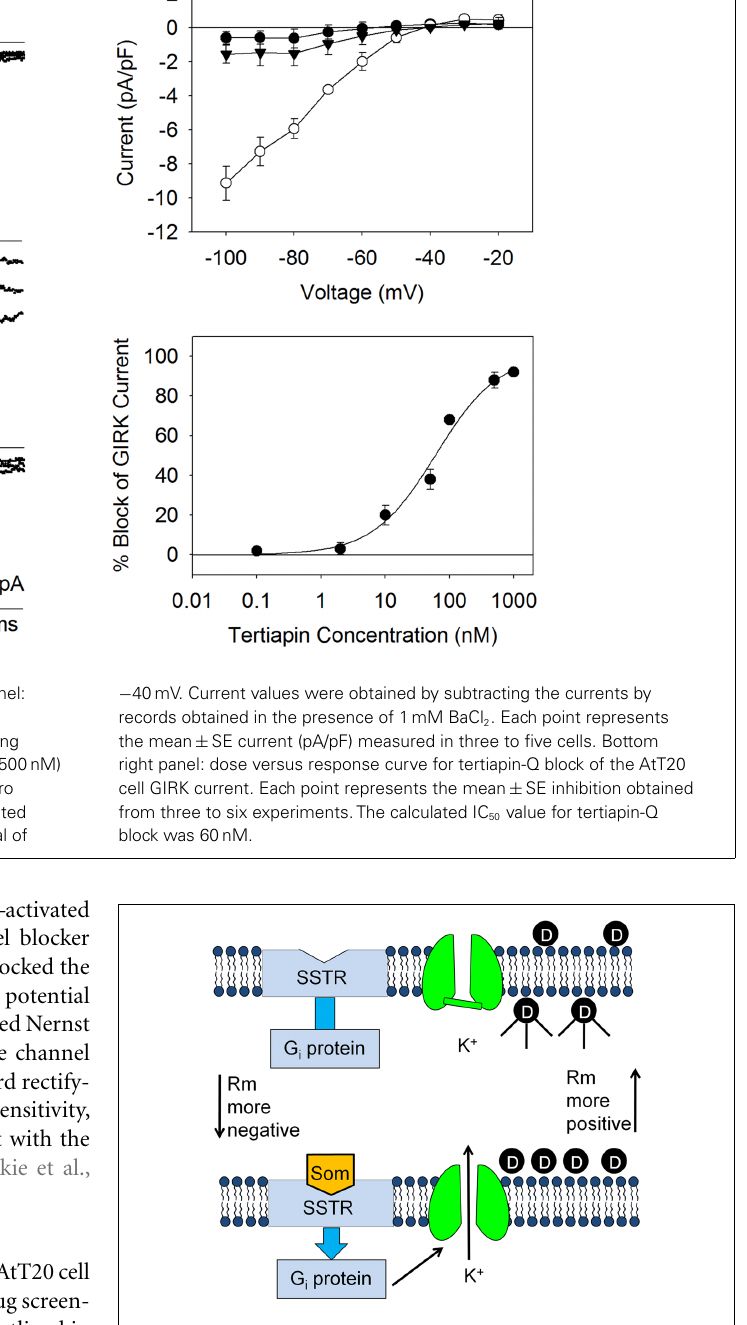
FIGURE 2 | Development of a screening assay for identifying new neuronal GIRK channel blockers.